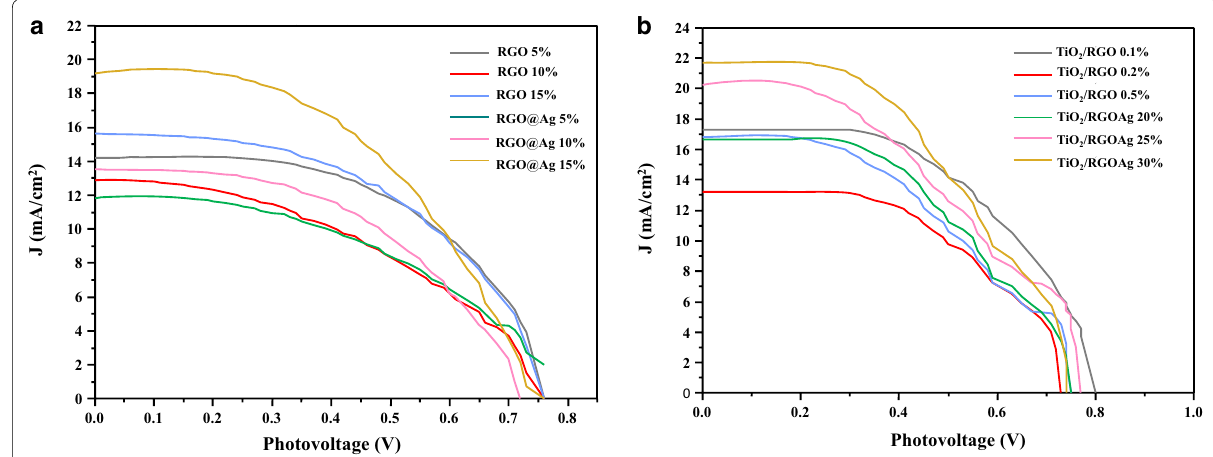
Fig. 7 J – V characteristics of different ( a ) counter electrodes and ( b ) different photoanodes in DSSC